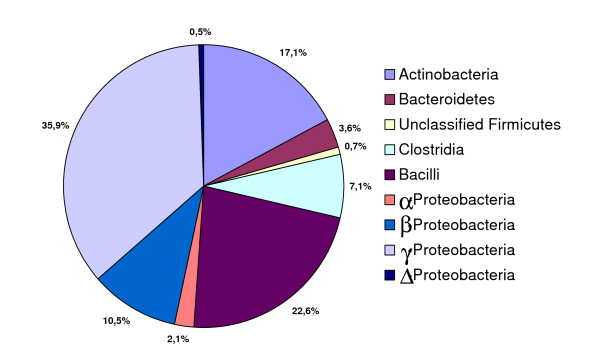
The total bacterial composition from eight intestinal tissue samples by 16S rRNA gene clone library. The γ-Proteobacteria dominated the total bacterial composition whereas the class Clostridia only accounted for a total of 7.1%